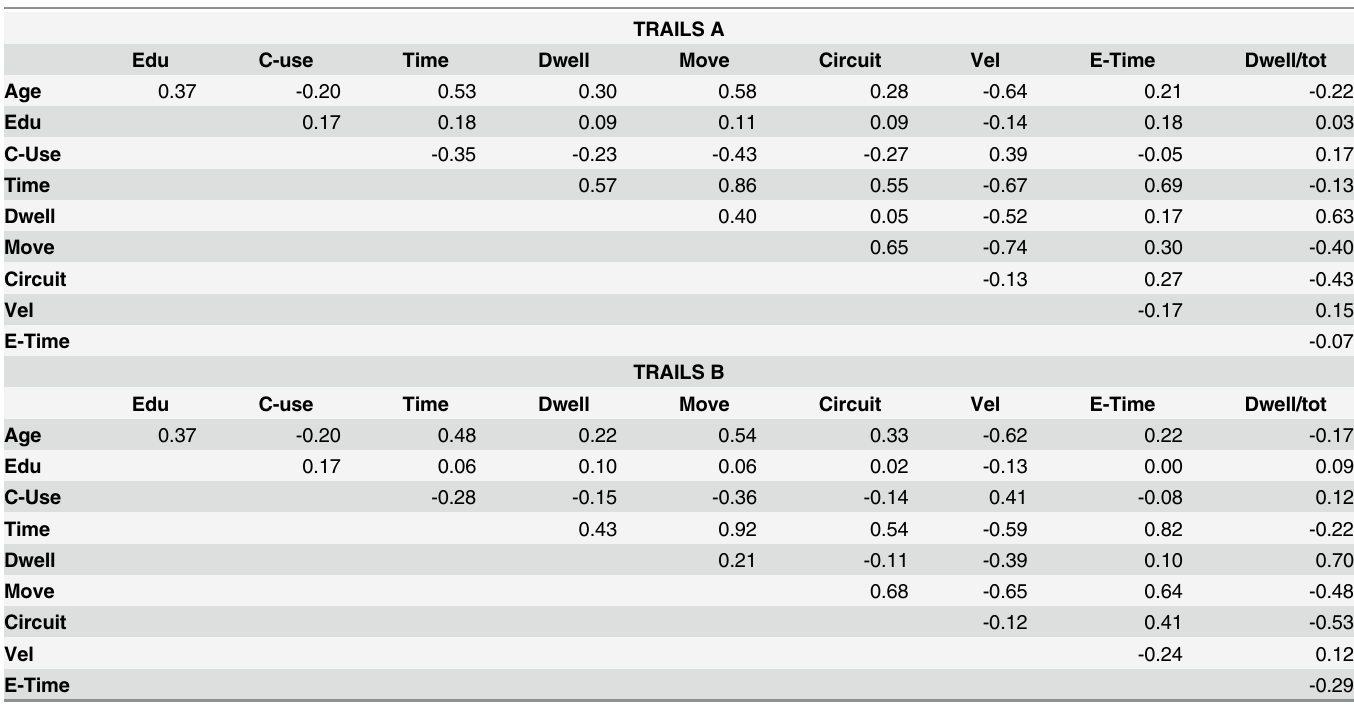
Table 5. Correlation matrix of CTMT-A and C-TMT-B metrics from Experiment